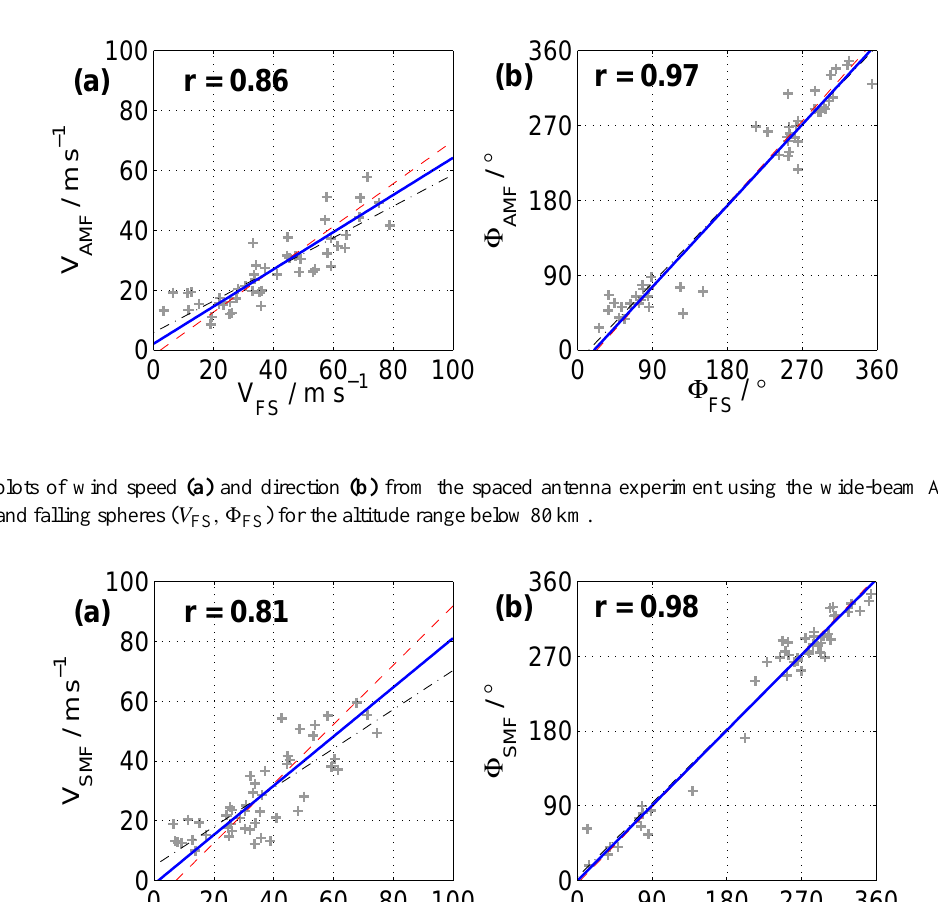
direction. The height resolutions of the two methods are